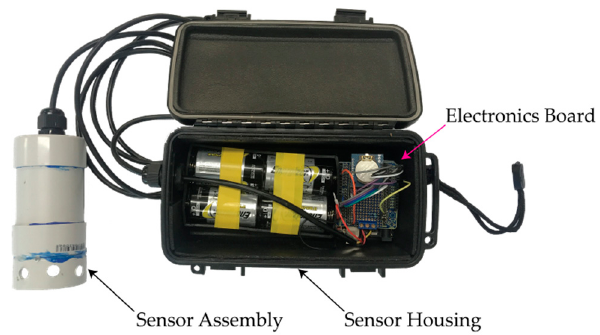
Figure A1. Example of a completed low-cost sensor and housing layout.